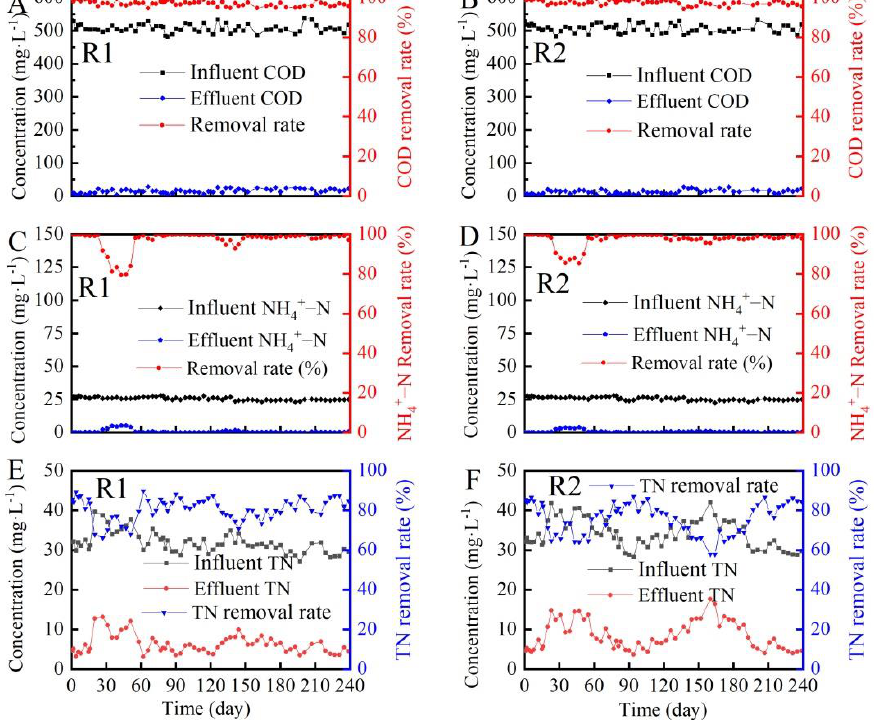
Figure 5. Performance of R1 and R2 with aerobic granular sludge. ( A , C , E ) for R1; ( B , D , F ) for